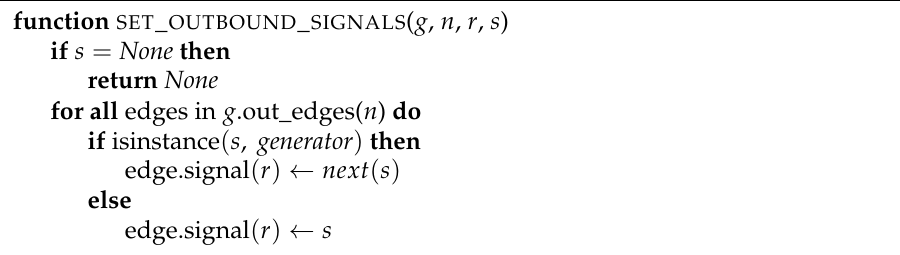
Algorithm 5 Set outbound edges with activation